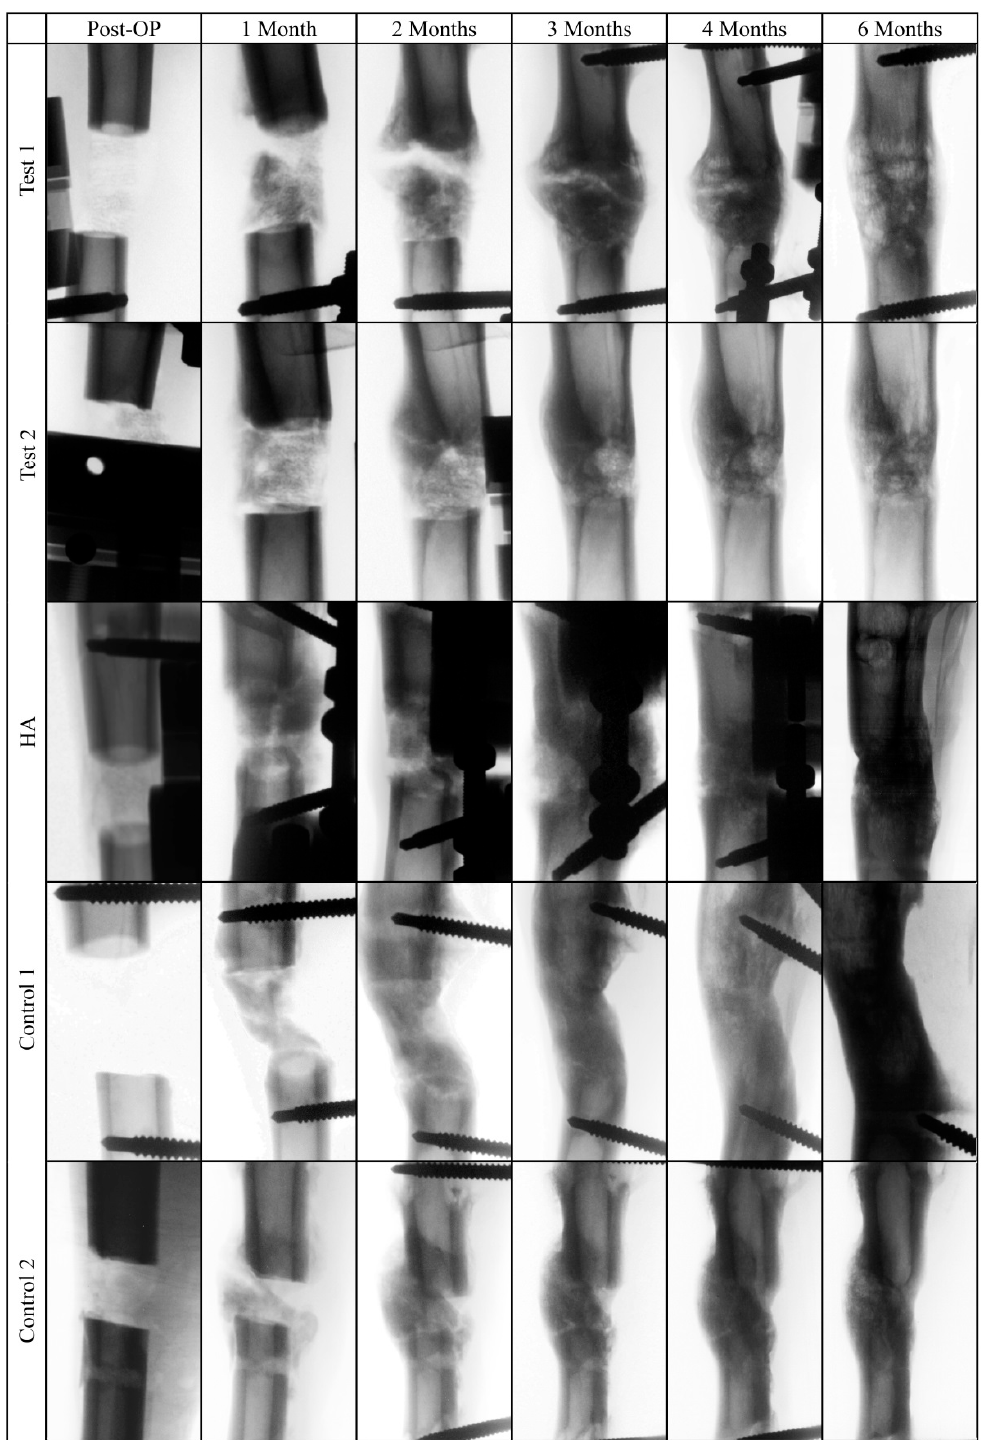
Figure 4. Representative invers radiograph images of the tibial bone defect area after surgery and after one, two, three, four, and six months.